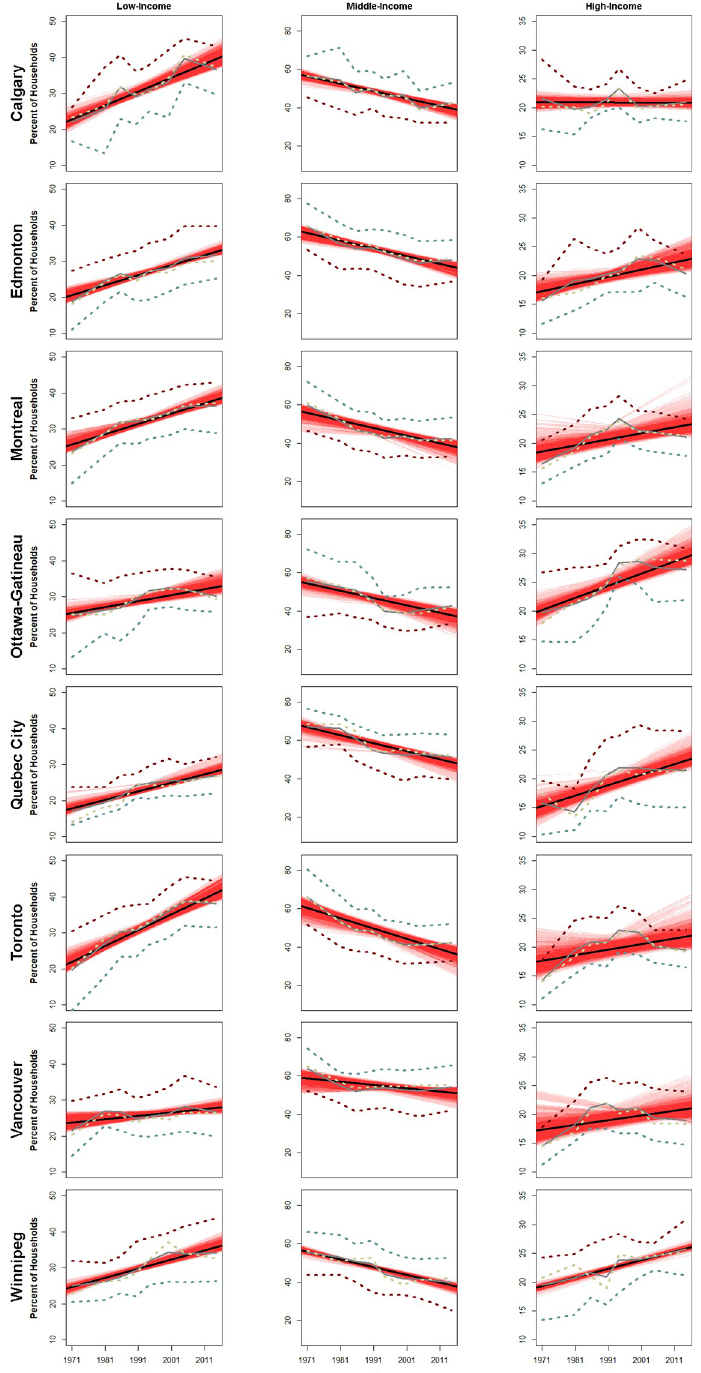
Fig 2. The percentage of households in low, middle and high-income classes, in Canada’s largest eight CMAs. Each column has a different y axis, but each panel within the same column has the same axis range. Different definitions of the middle are shown (blue: ± 25 percent of average, yellow: ± 20 percent of average, dark red: ± 15 percent of average), with grey being the composite average. Confidence intervals of the linear trend of the average of the three bandwidths are shown in red. A bootstrapped confidence interval that does not cross zero indicates a statistically significant result.